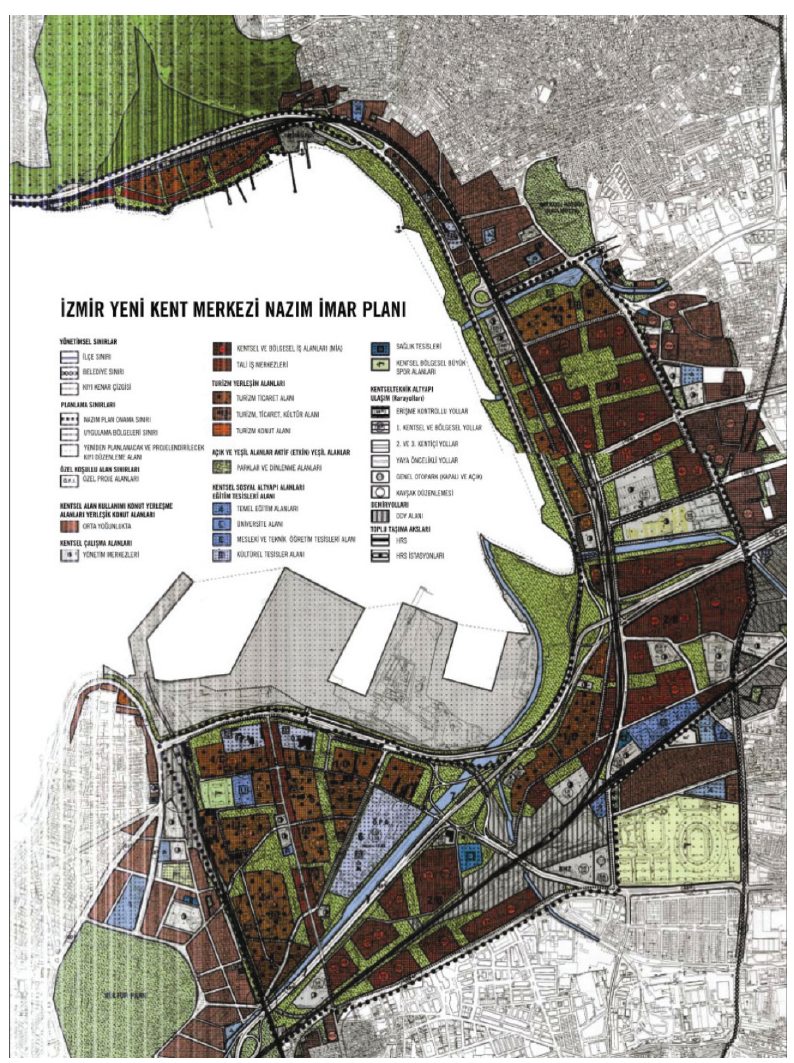
Figure 3. The 1/5000 Master Plan of İ zmir’s New Downtown (p. 55) [32]. Reproduced with permission from Erdik, A.; Kaplan, A. Aegean Geographical Journal; published by Aegean University Department of Geography,